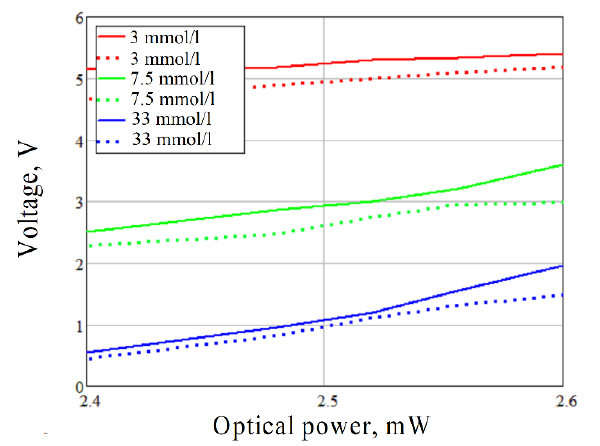
Fig. 5. Dependency of outlet voltage of photodiodes on the power of incident radiation in the system of the optical glucometer with (uniform line) / and without (dotted line) of ellipsoidal reflectors in the backscattered